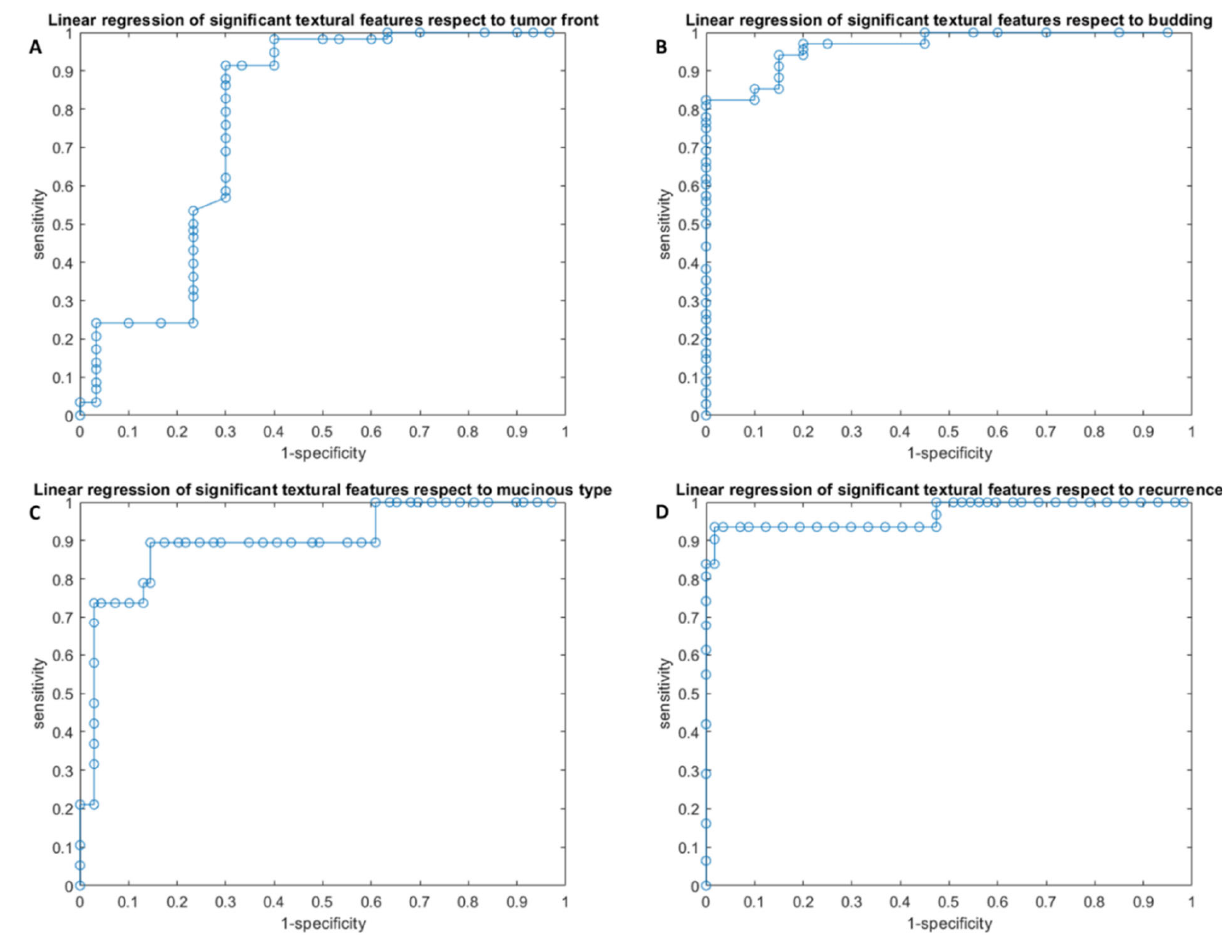
Figure 1. ROC curves of linear regression analysis with respect to the front of tumor growth ( A ), tumor budding ( B ), tumor mucinous type ( C ), and recurrence presence ( D ) obtained considering significant features. Table 5. Linear regression model